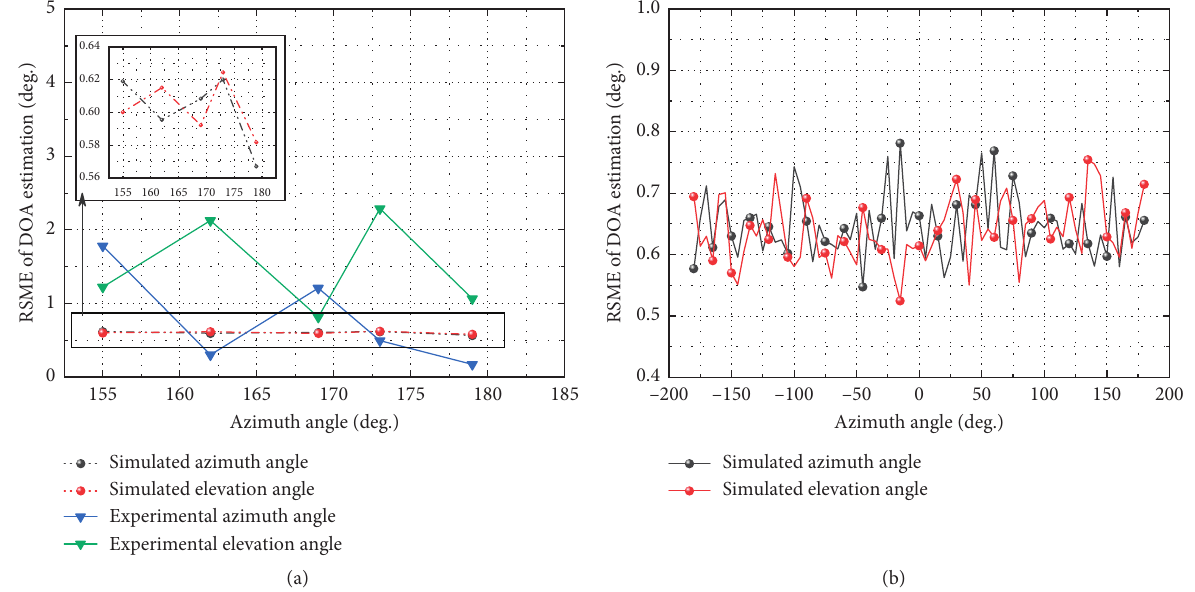
Figure 10: RMSE of DOA estimation under different azimuth angles when side length of antenna aperture is 4m and elevation angle is 30.31 degrees. (a) Comparison between the experimental results and simulation results. (b) Simulation results under azimuth angle of − 180–180 degrees.